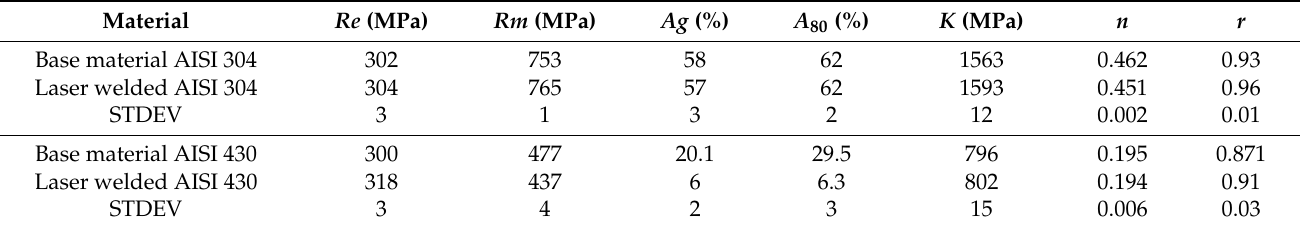
Table 4. The properties (at 90 ◦ to rolling direction) of base material and laser-welded material.